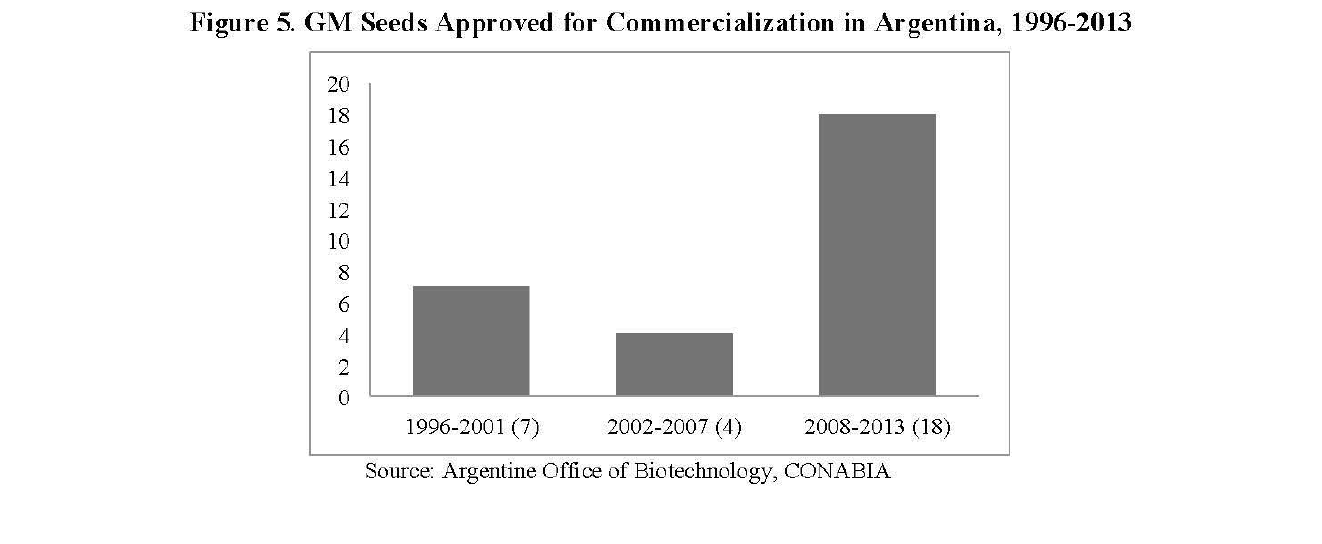
Figure 5. GM Seeds Approved for Commercialization in Argentina, 1996-2013